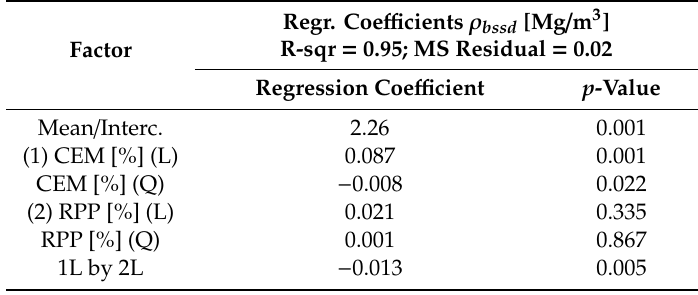
Table 8. Experimental coe ffi cients for bulk density ρ bssd .